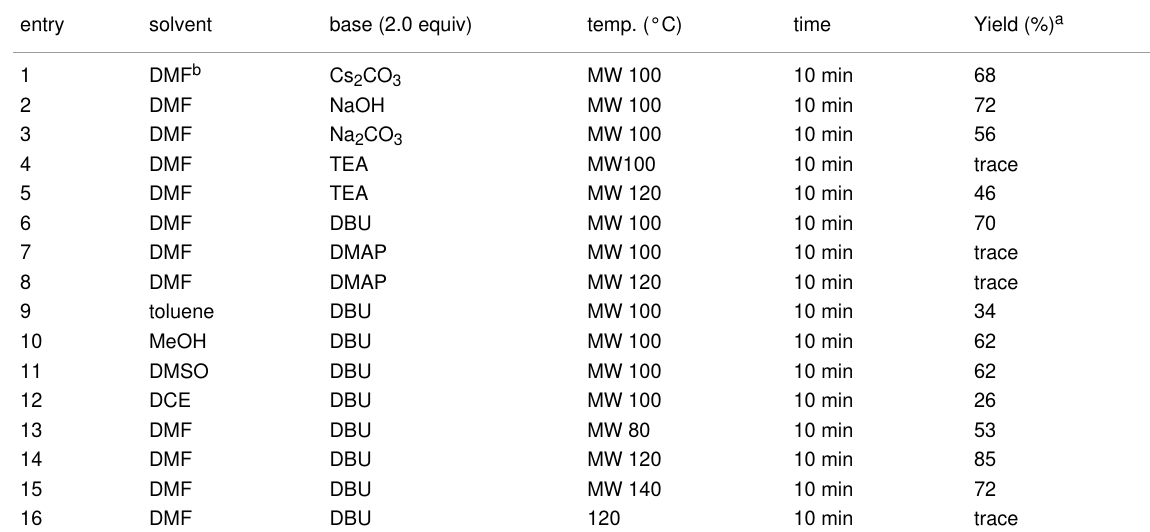
Table 1: Optimization of the Dieckmann reaction for compound 7a